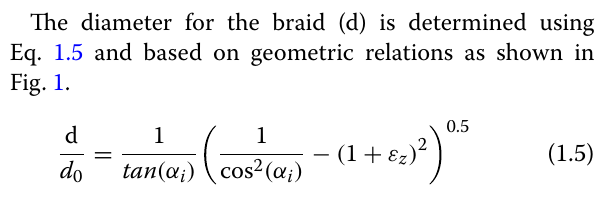
D c Diameter of the core D b Diameter of the braid